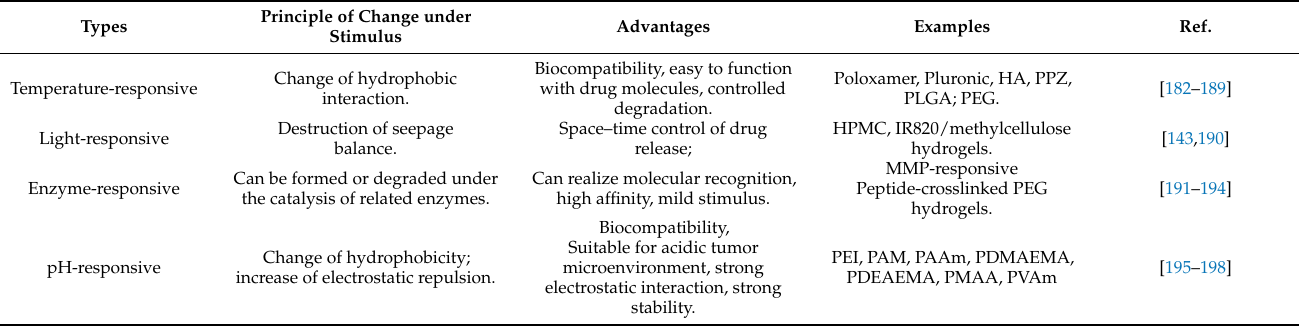
Table 1. The differences between the various types of stimulus-responsive